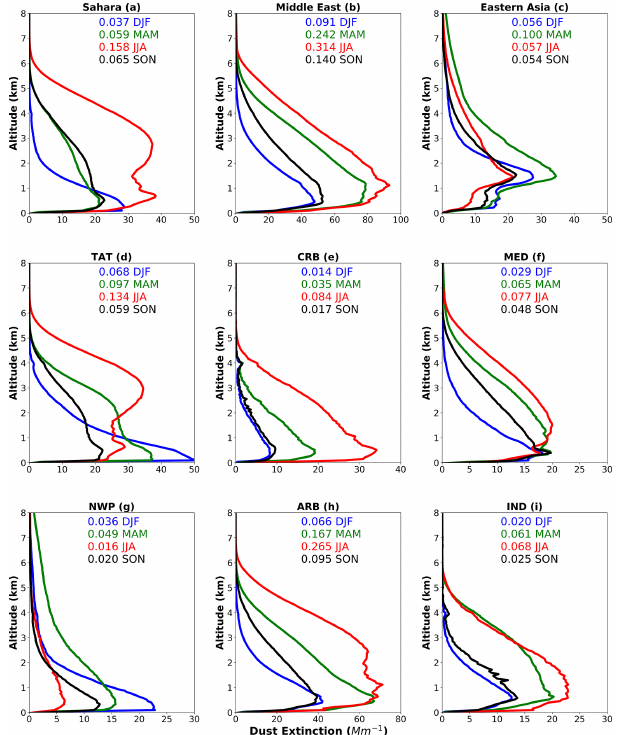
Figure 11. Vertical profiles of seasonal mean dust extinction coef- ficient (Mm − 1 ) in nine dust-laden regions indicated in Fig. 4. Dif- ferent colors represent different seasons. The numbers on each plot are the seasonal mean DAOD for the